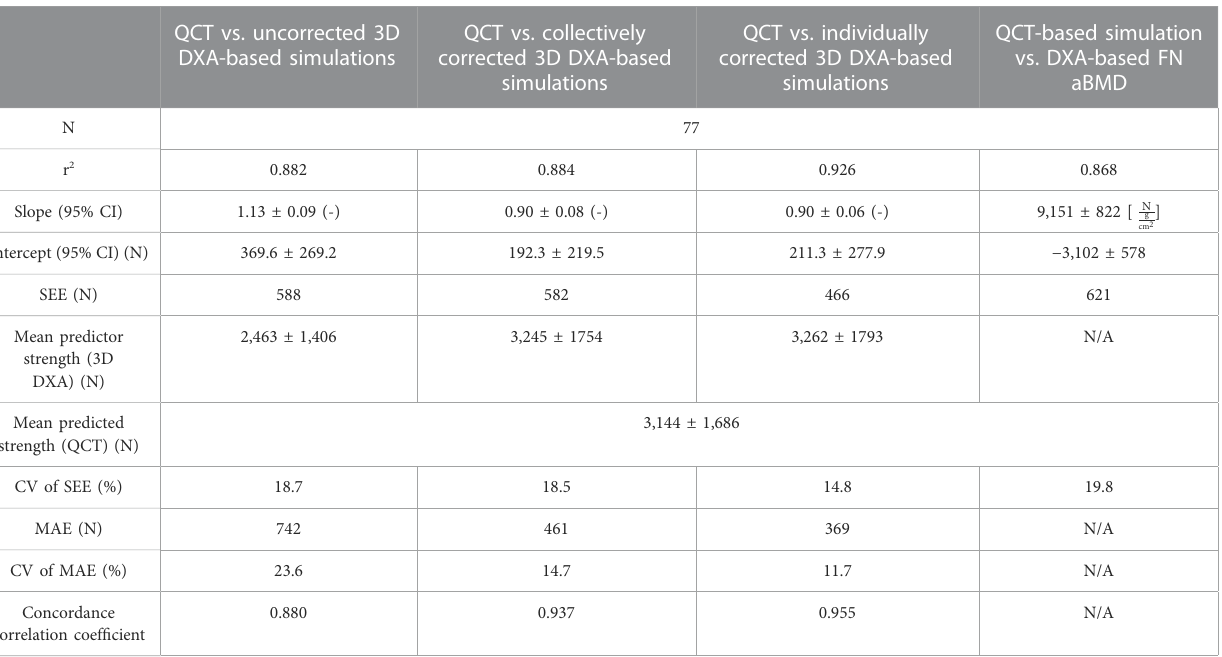
TABLE 6 Summary of linear regression results, error measures, and